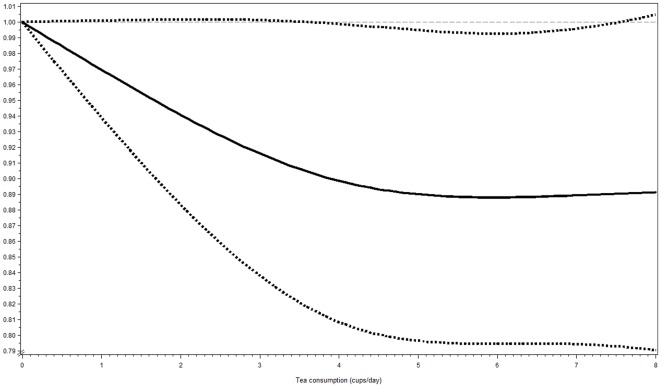
Association between tea consumption based on data from a food frequency questionnaire and risk of type 2 diabetes obtained by spline regression with 3 knots (1, 4, 7 cups per day) and 0 cups per day as reference (n = 26,039).Dotted lines represent 95% confidence intervals (95%CI). P
non-linearity = 0.20. Hazard ratios were adjusted for sex, smoking status, physical activity level, education level, intake of energy, protein, carbohydrates, saturated fatty acids, mono-unsaturated fatty acids, poly-unsaturated fatty acids, alcohol, fiber, coffee, juices, soft-drinks, milk, and body mass index.